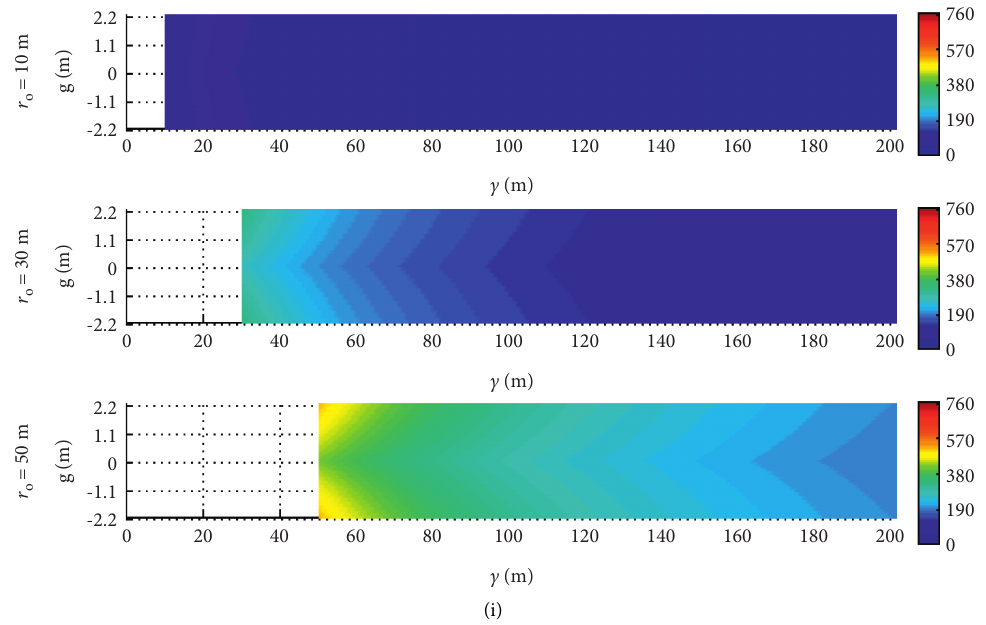
Figure 10: Explosion wave peak pressure nephograms (kPa). (a) C � 6% and T �− 2260 ° C. (b) C � 10% and T � − 60 ° C. (c) C � 12% and T �− 60 ° C. (d) C � 6% and T � +0 ° C. (e) C � 10% and T � +0 ° C. (f) C � 12% and T � +0 ° C. (g) C � 6% and T � +60 ° C. (h) C � 10% and T � +60 ° C. (i) C � 12% and T � +60 °